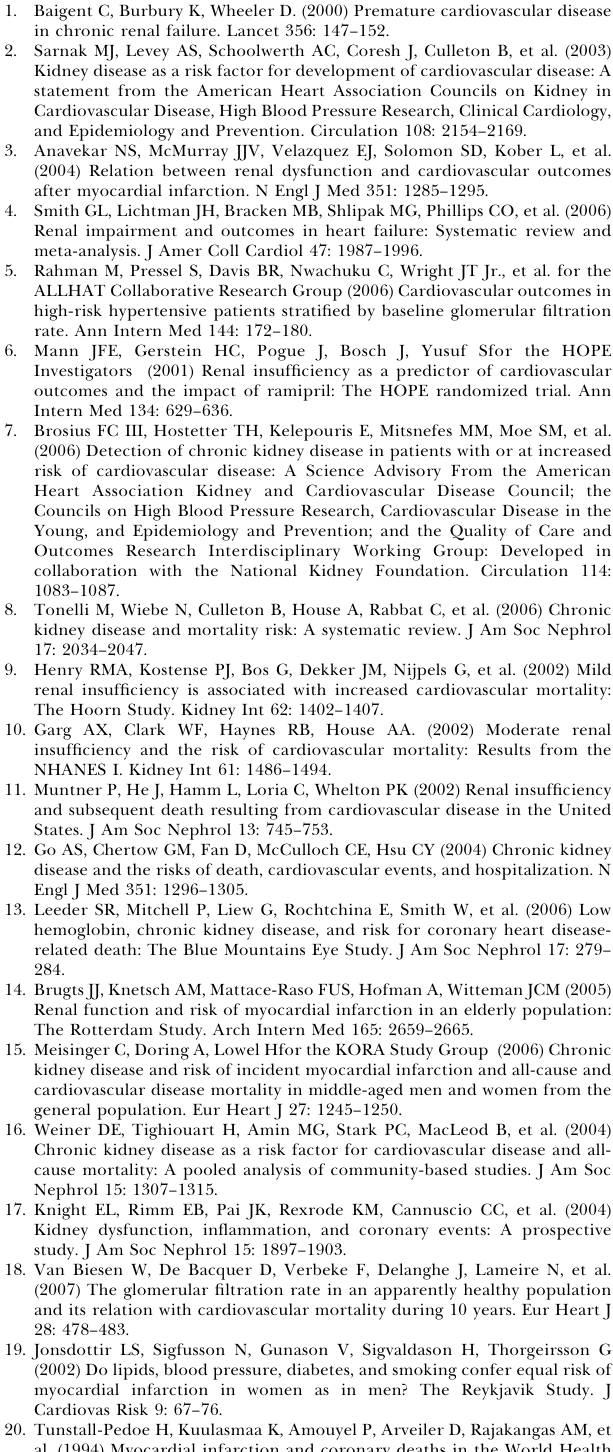
Figure S1. Association between Baseline eGFR CG and CHD Adjusted for Age, Sex, Period, Smoking Status and Other Established Risk Factors Found at doi:10.1371/journal.pmed.0040270.sg001 (32 KB PPT). Figure S2. Risk of CHD in Individuals with Baseline eGFR MDRD and eGFR CG , 60 Versus (cid:3) 60 ml/min/1.73 m 2 , Grouped According to Various Characteristics Table S1. Characteristics of the CG Equation, the Simplified MDRD Equation, and Creatinine to Estimate the Glomerular Filtration Rate Found at doi:10.1371/journal.pmed.0040270.st001 (34 KB DOC). Table S2. Baseline Correlates of eGFR CG in Controls Found at doi:10.1371/journal.pmed.0040270.st002 (90 KB DOC). Table S3. Relative Odds (95% CI) of CHD According to the Baseline eGFR CG and Creatinine Levels Found at doi:10.1371/journal.pmed.0040270.st003 (57 KB DOC). Table S4. Relative Odds (95% CI) of CHD According to the Baseline eGFR MDRD and eGFR CG , 60 Versus (cid:3) 60 ml/min/1.73 m 2 Found at doi:10.1371/journal.pmed.0040270.st004 (38 KB